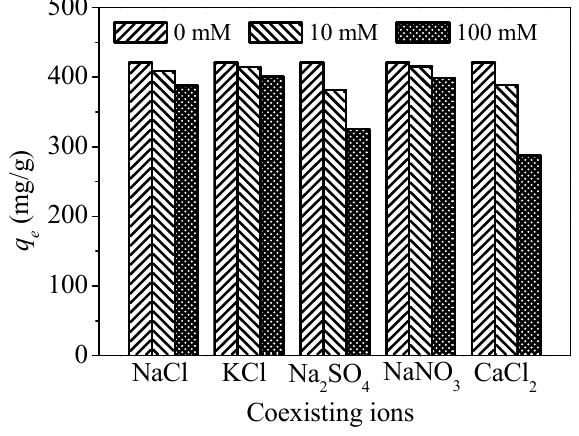
Figure 15. Effect of coexisting ions.